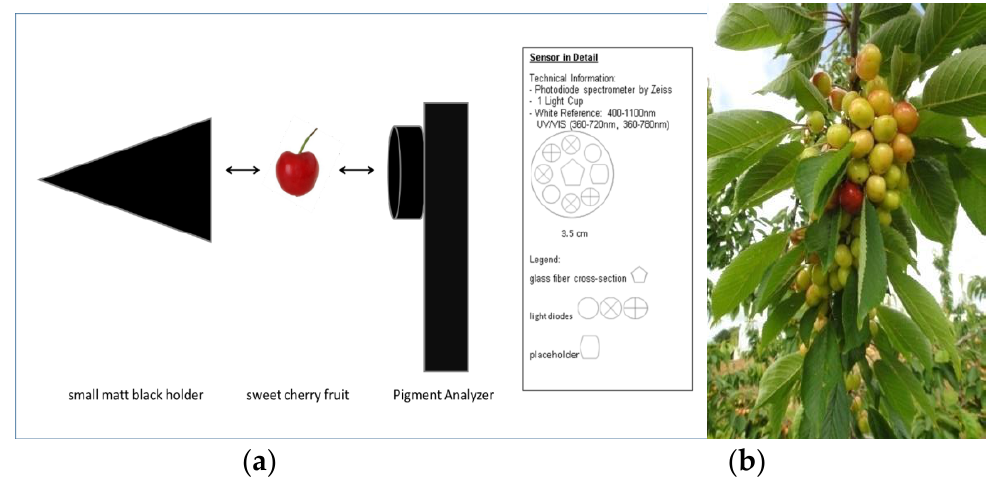
Figure 1. Sensor technology ( a ) to non-destructively determine normalized anthocyanin index (NAI) and normalized differential vegetation index (NDVI) of sweet cherry fruit; an existing PA (Pigment Analyzer type 1101) was modified; a matt black holder was built for the device to reduce stray light and ( b ) “breaker stage” of the cherry fruit from green to yellow, measurements should begin before this stage in the proposed method.